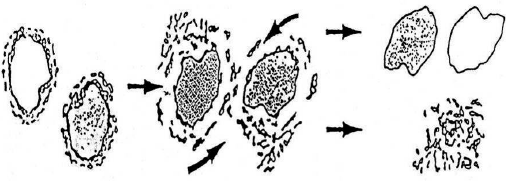
Figure A3. Schematic diagram of matrix release from coatings of used binding material—result of elementary rubbing operation [3].